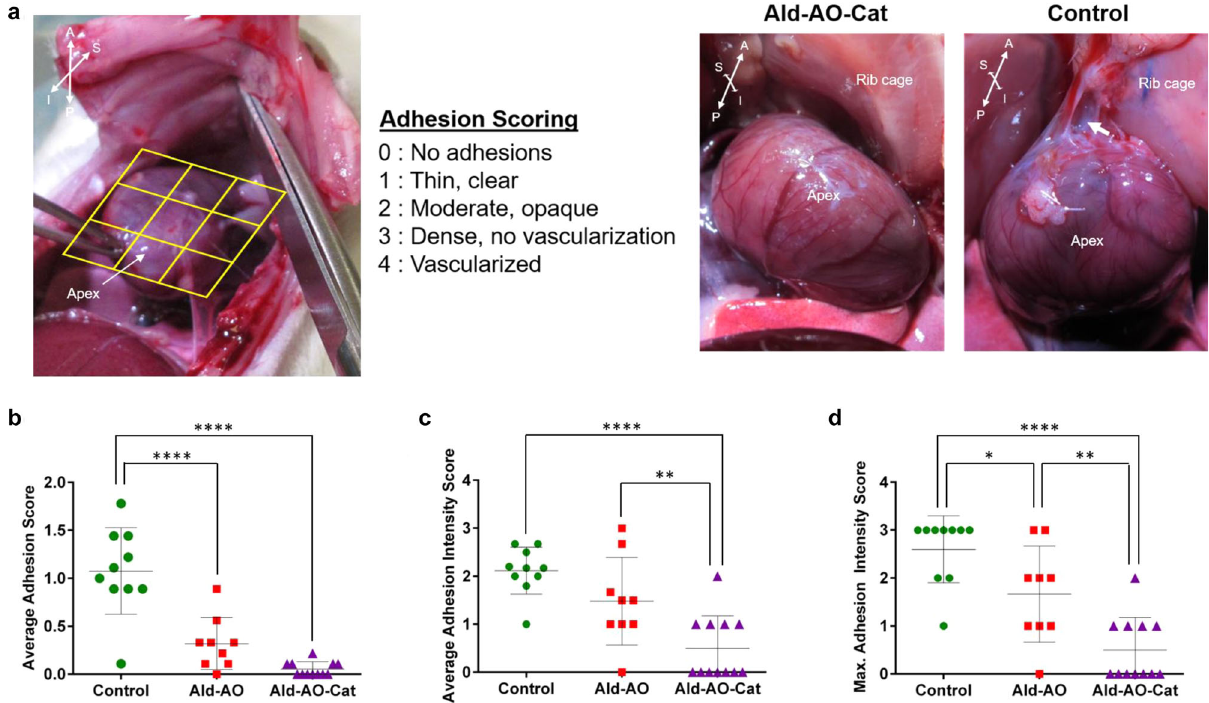
Fig. 4 Reduced adhesion formation 2 weeks after application in rat surgical model. Adhesion formation was assessed for administration of Ald – AO – Cat, Ald – AO, and the untreated control after 2 weeks. a Adhesion scores were assigned to 9 discrete segments of the exposed heart surface when the chest was re-entered during euthanasia and harvest. Representative images of adhesions upon re-entry for Ald – AO – Cat and control groups are shown. Anatomical directions are shown to provide a point of reference: A — anterior, P — posterior, S — superior, I — inferior. b The individual scores for the 9 segments were averaged to obtain the adhesion score for each heart. At 2 weeks there was a signi fi cant reduction in adhesion score for Ald – AO – Cat and Ald – AO compared to the untreated group. c The average intensity score was calculated over regions of adhesion formation. At 2 weeks, Ald – AO – Cat show signi fi cantly reduced adhesion intensity compared to Ald – AO and the untreated control. d The maximum adhesion intensity score was also reported for each animal. Signi fi cantly higher maximum intensity scores were assigned to adhesions in rats treated with Ald – AO and the untreated group, compared